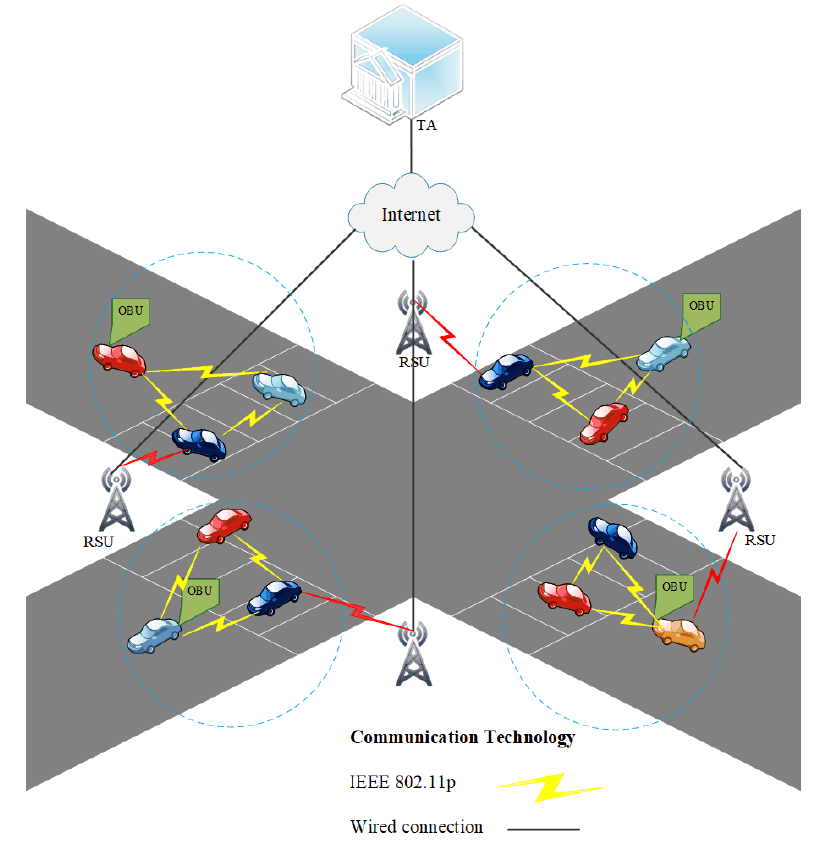
Figure 1. A Typical VANET Scenario.